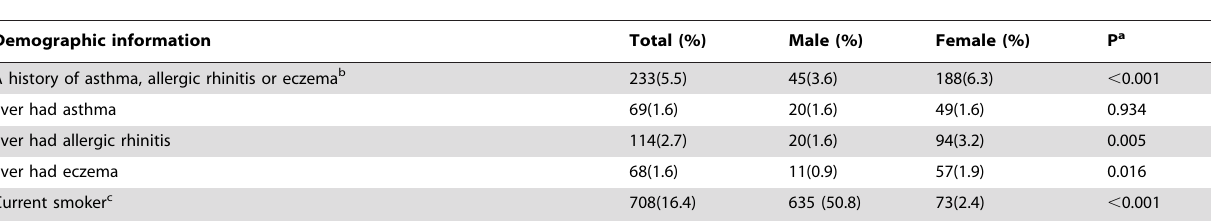
Table 1. Demographic information on participating parents (n= 4530).